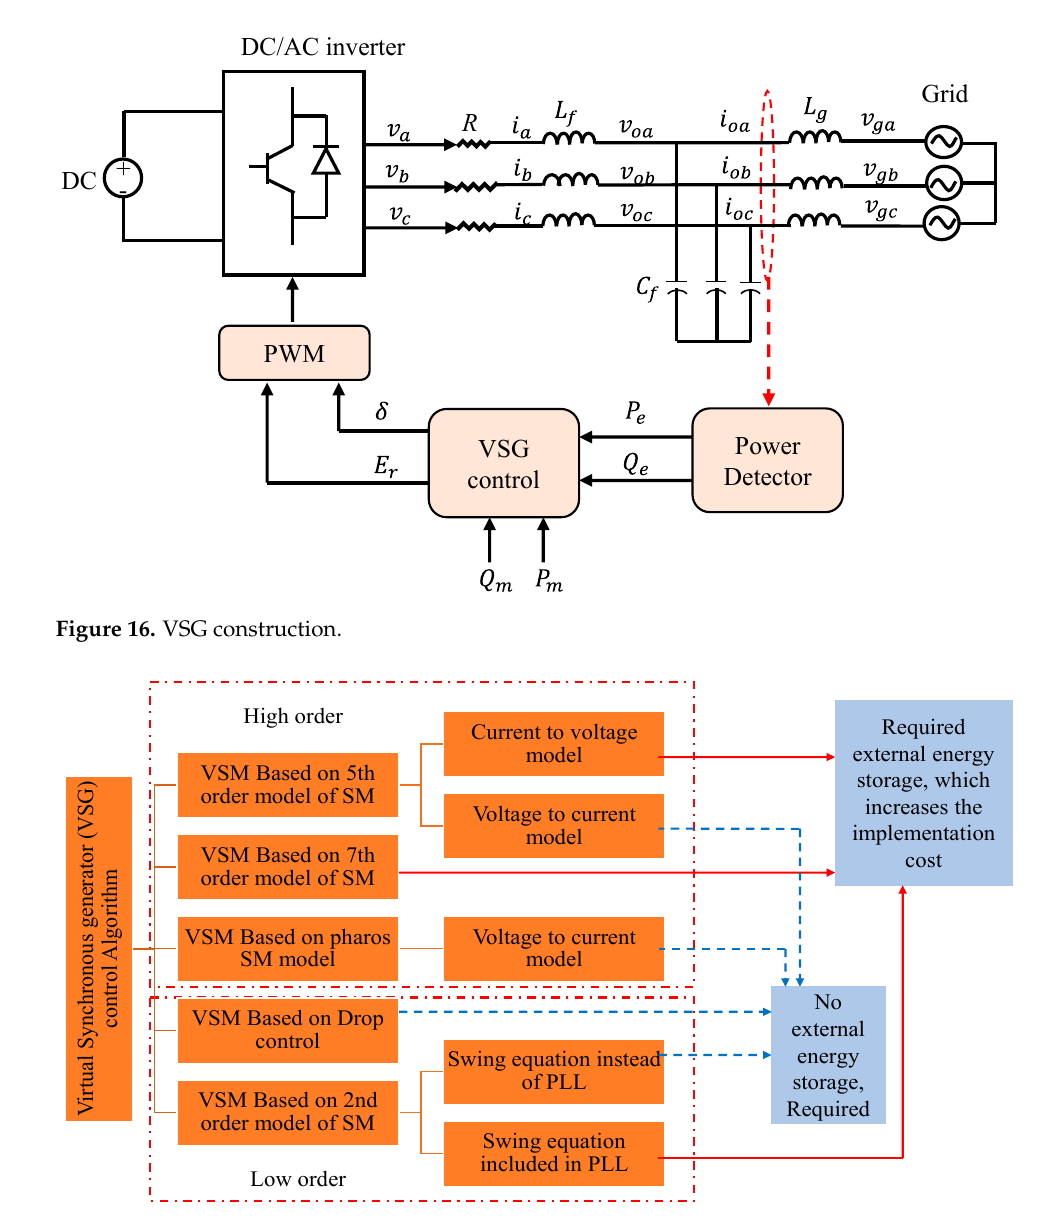
Figure 18. High-order VSG models: ( a ) voltage-to-current model, and ( b ) current-to-voltage model [42,44].